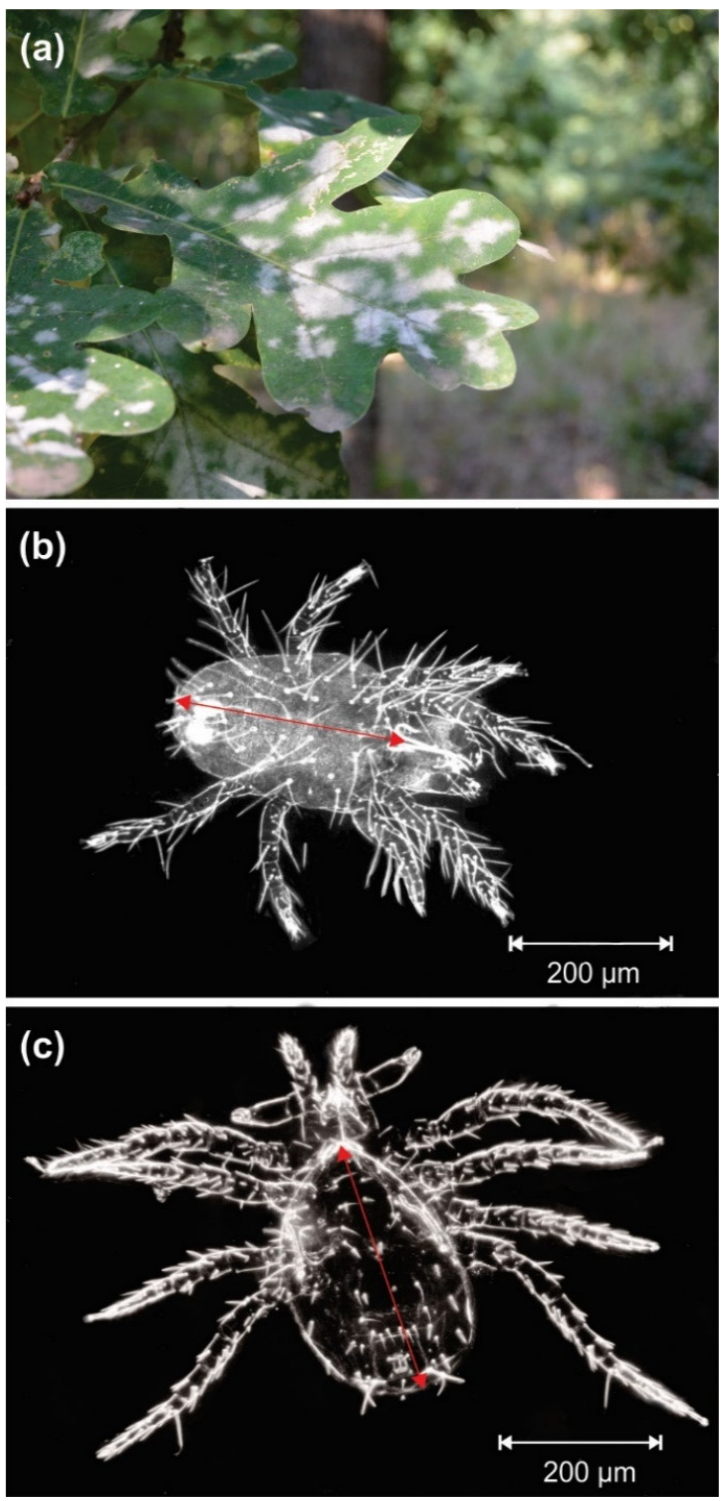
Figure 1. ( a ) White powdery patches of Erysiphe alphitoides on the upper side of a Quercus robur leaf, and dorsal side of adult females of ( b ) the phytophagous mite Schizotetranychus garmani and ( c ) the predatory mite Euseius finlandicus. Red arrows indicate idiosoma length. Ten of the 50 leaves sampled from each tree were placed separately into plastic Petri dishes. Leaf petioles were wrapped in cotton moistened with sterile distilled water.